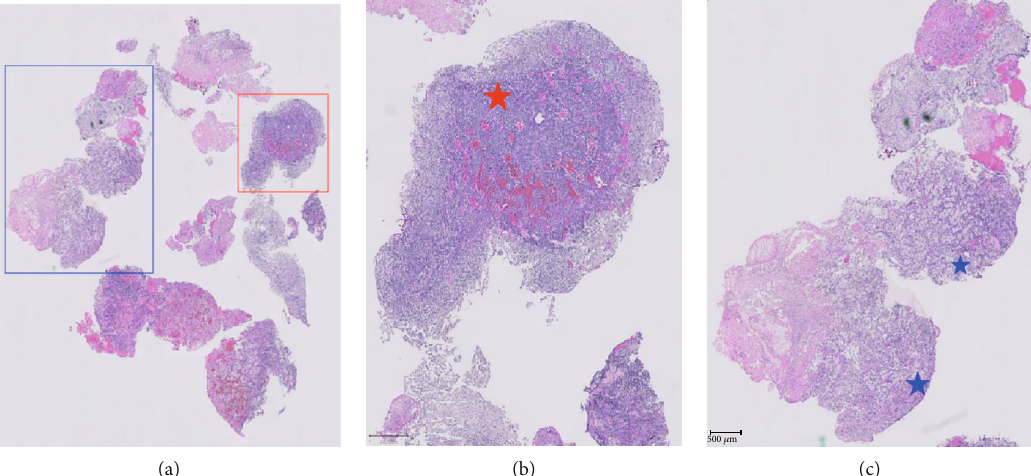
Figure 4: Histopathologic stains of the pituitary mass. (a) H and E stain of the pituitary lesion. (b) Magni fi ed image of red box in a showing evidence of pituitary adenoma which is surrounded by clear cells that resemble RCC but without the nuclear changes. (c) Magni fi ed image of blue box in (a) showing clear cytoplasm arranged in nests with severe nuclear atypia consistent with WHO/ISUP grade 3